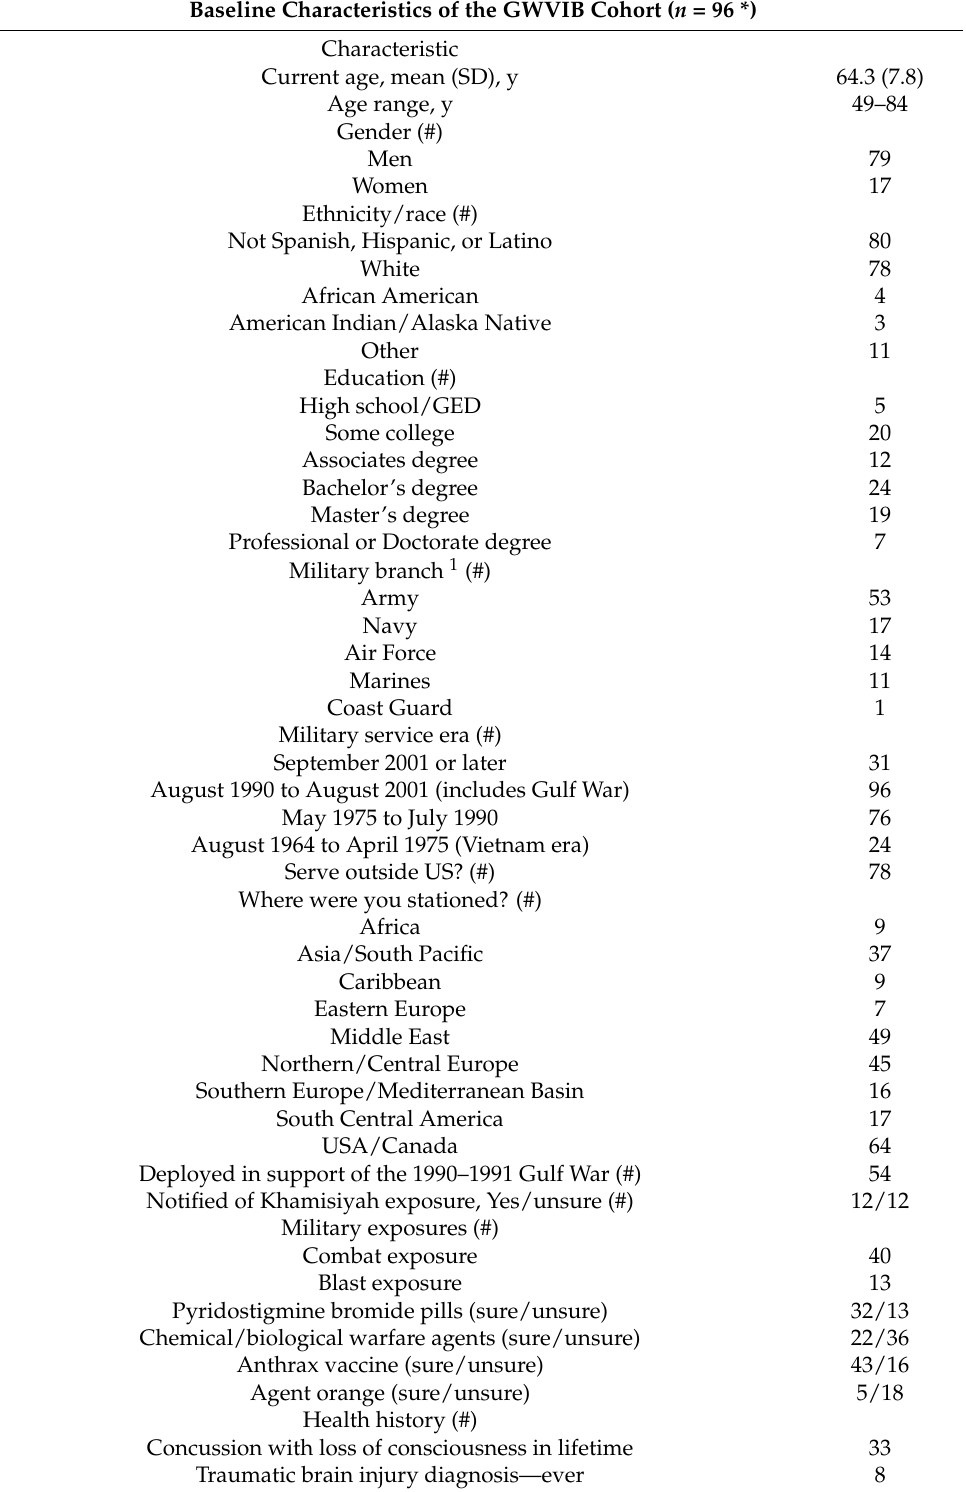
Table 1. Characteristics of the GWVIB